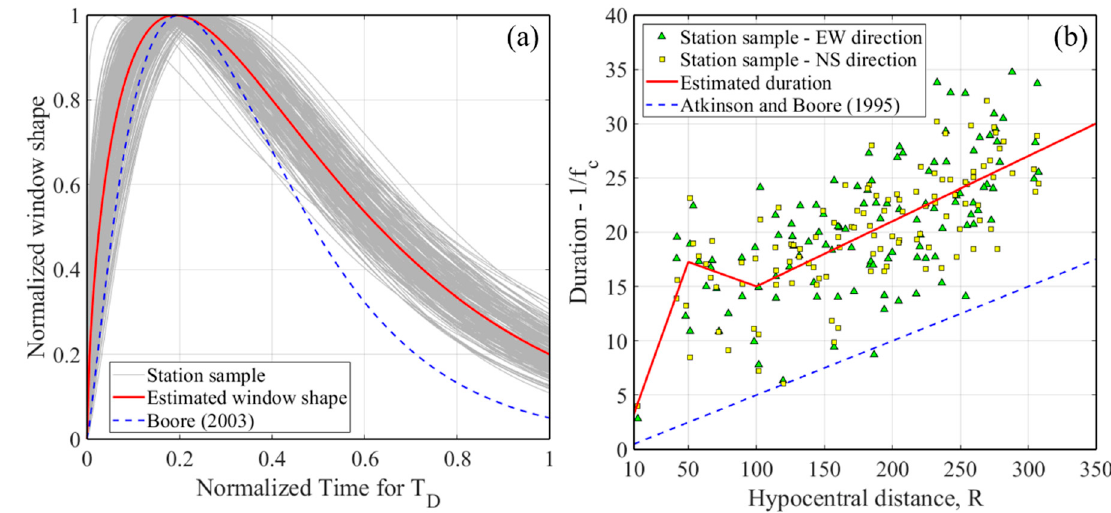
Figure 10. Estimated shaping window and duration at the BUS2 station for the 2017 Pohang